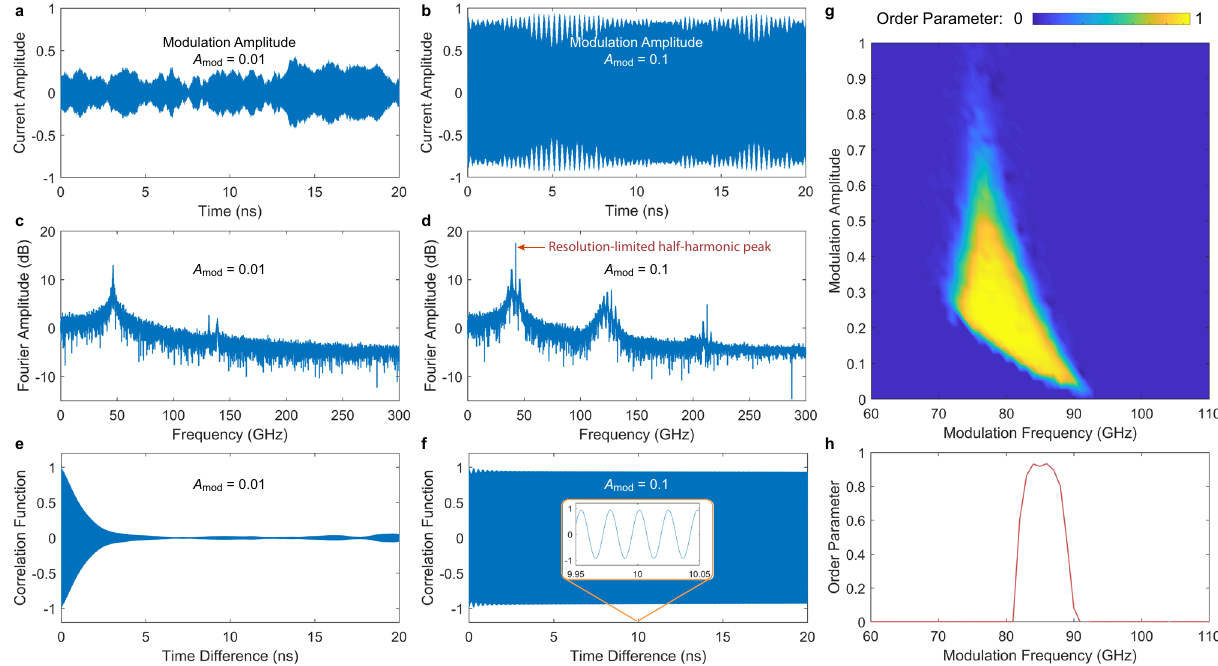
Fig. 2 Calculation on an effectively 0D single-layer short Josephson junction in BSCCO at 4 K under parametric modulation. The junction area is L × W = 4 μ m 2 and the Josephson plasma frequency is f p = 47 GHz. a Time trace of the current density j z ( t ) under a modulation frequency f mod ¼ 85 GHz and small modulation amplitude A mod ¼ 0 : 01. The system does not converge to a Floquet steady state. b Time trace of j z ( t ) under a large modulation amplitude A mod ¼ 0 : 1. The system has reached the Floquet steady state. c Fourier transform to j z ( t ) in ( a ), plotted in the magnitude of ∣ j z ( f ) ∣ . d Fourier transform to j z ( t ) in ( b ), showing a resolution-limited sharp half-harmonic generation around the Josephson plasma frequency. e Time-averaged current − current correlation function g ( δ t ) for f ¼ 85 GHz and small modulation amplitude A ¼ 0 : 01. f Time-averaged correlation function g ( δ t ) for a large mod mod ¼ 0 : 1, showing an ordered temporal pattern. g Phase diagram of temporal order parameter Δ modulation amplitude A t for an ensemble of 50 junctions mod versus the modulation frequency f mod and amplitude A mod (with fi xed f p , temperature T = 4 K, and thermal noise). Clear phase boundaries can be identi fi ed. h Temporal order parameter versus f mod when A mod ¼ 0 : 1, showing a parametric excitation band within 80 − 90